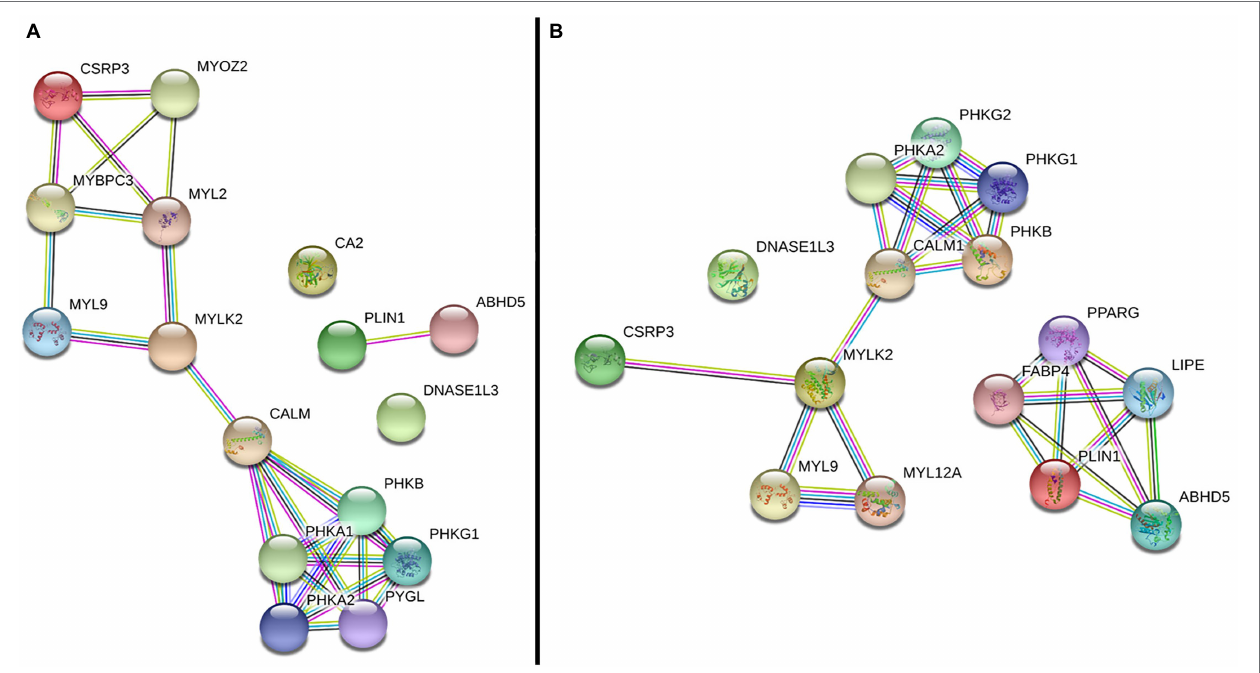
FIGURE 2 | Gene network performed with differentially expressed (DE) genes between normal and WS-affected broilers, obtained with the String database using Gallus gallus (A) and Homo sapiens (B) protein information. Circles represent the genes. Lines represent the interaction among the DE and other related genes based on the prediction methods: known interaction in curated databases (light blue) and experimentally determined (magenta), predicted co-occurrence (blue), gene fusion (red) or neighborhood (green), homology (purple), text mining information (yellow), and co-expression